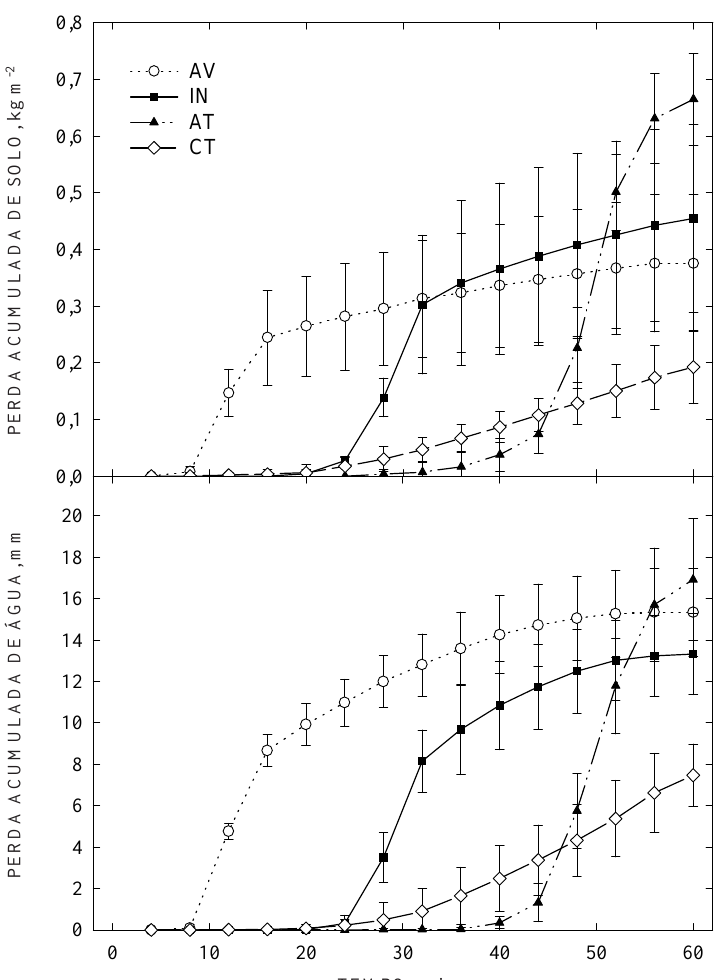
Figura 4. Perdas acumuladas de solo e água nos padrões de chuva avançado (AV), intermediário (IN), atrasado (AT) e constante (CT), observadas durante a chuva proposta, com intervalo de 95% de